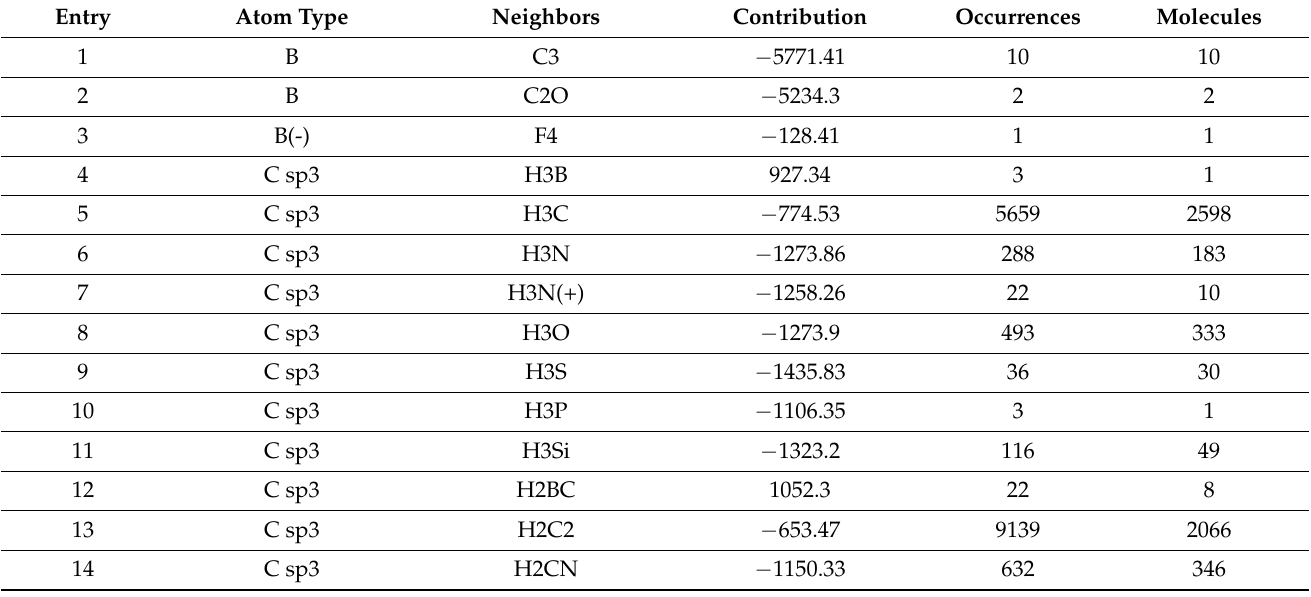
Table 4. Atom Groups and their Contributions to ∆ H ◦ (c) Calculations (in